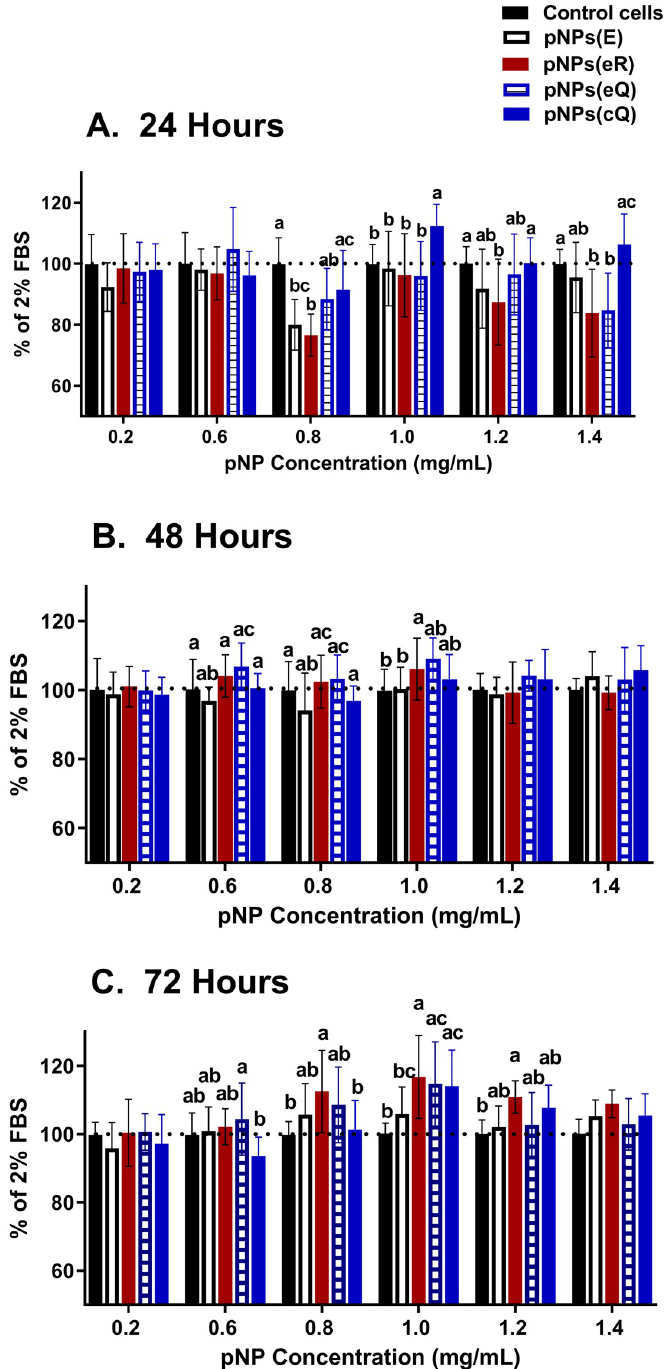
Fig 4. Rat aortic smooth muscle cells loaded for 2 hours with empty pNPs (pNPs(E)), entrapped quercetin (pNPs (eQ)), covalent quercetin (pNPs(cQ)) and entrapped rhamnazin (pNPs(eR)) exhibit only mild cytotoxicity at A) 24, B) 48 and C) 72 hours. Cytotoxicity, assessed as relative ATP levels using a luminescent assay, was compared to control cells treated with no pNPs. Data are means ± SD for n = 12. Two-way ANOVA revealed a significant effect of treatment. Means denoted by unlike letters represent significant differences for the same dose, revealed using Bonferroni’s post-hoc tests.